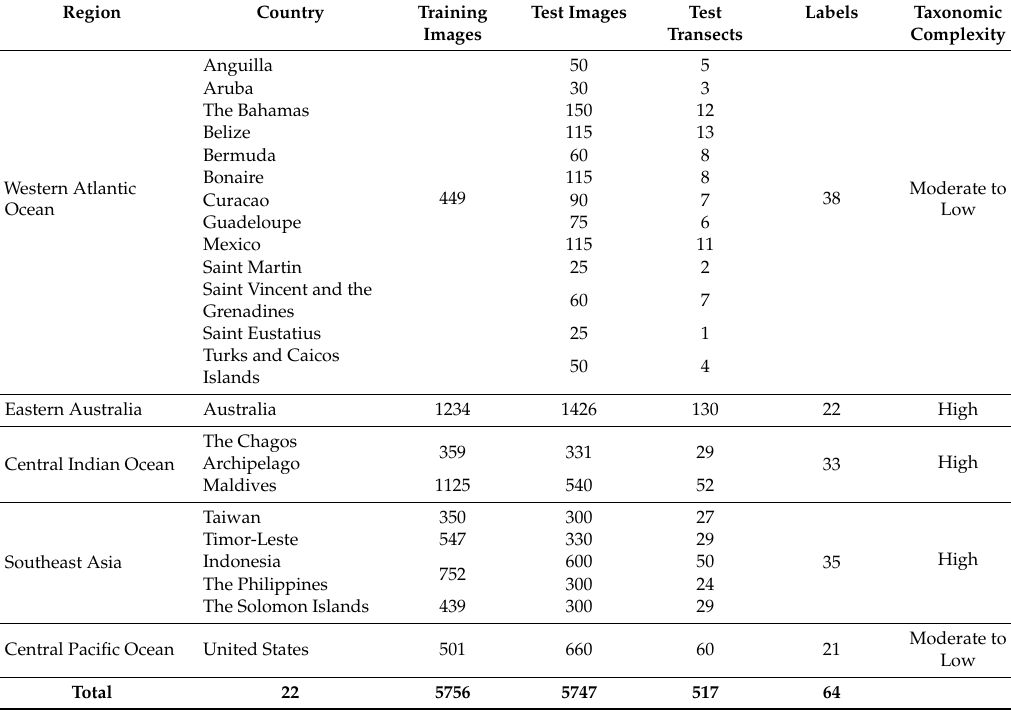
Table1. Summarystatisticsofdataemployedforthisstudy. Thisincludesthenumberoftestandtraining images, labels and taxonomic complexity of the label-set used per region in the classification